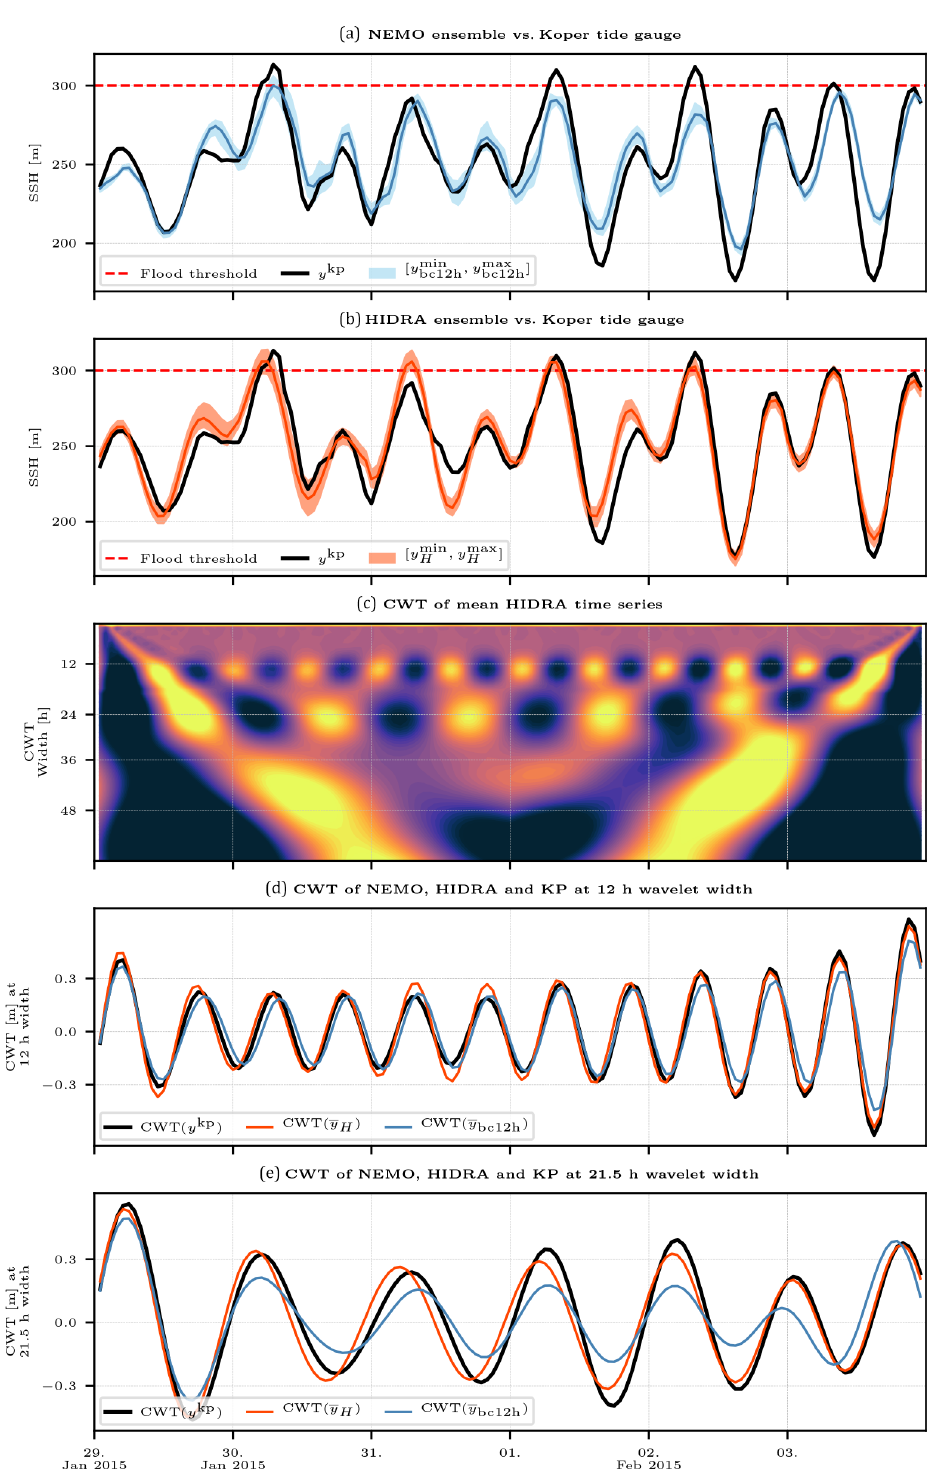
Figure 12. Comparison between NEMO (with a 12h bias correction) and HIDRA ensembles during a surge of January and February 2015. Panels (a) and (b) depict NEMO and HIDRA ensemble predictions for Koper sea level, together with Koper tide gauge time series. Mean values and minimum–maximum ensemble spans are depicted, as defined in Sect. 3.3. Panel (c) depicts a CWT of y H (t) HIDRA mean time series. Panels (d) and (e) depict CWTs of Koper tide gauge, HIDRA and NEMO time series at semi-diurnal (12h) and E 0 (21.5h) wavelet width respectively. Severe flooding threshold in the historic coastal town of Piran (Slovenia) is marked by a dashed red line in the top two